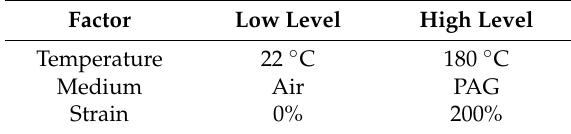
Table 1. Processing factors and their levels used in the DOE